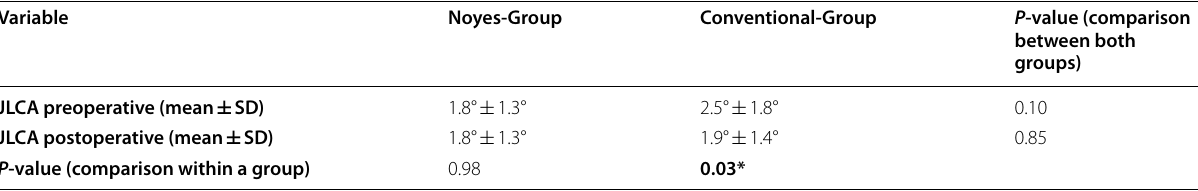
Preoperative and postoperative mean values of the joint line convergence angle (JLCA) for the Noyes- and Conventional-Group respectively. P -values are displayed for comparison of the mean JLCA from the pre- to postoperative visit within a group (last row) as well as for comparison of the JLCA between the groups (last column). Statistically significant values are marked by